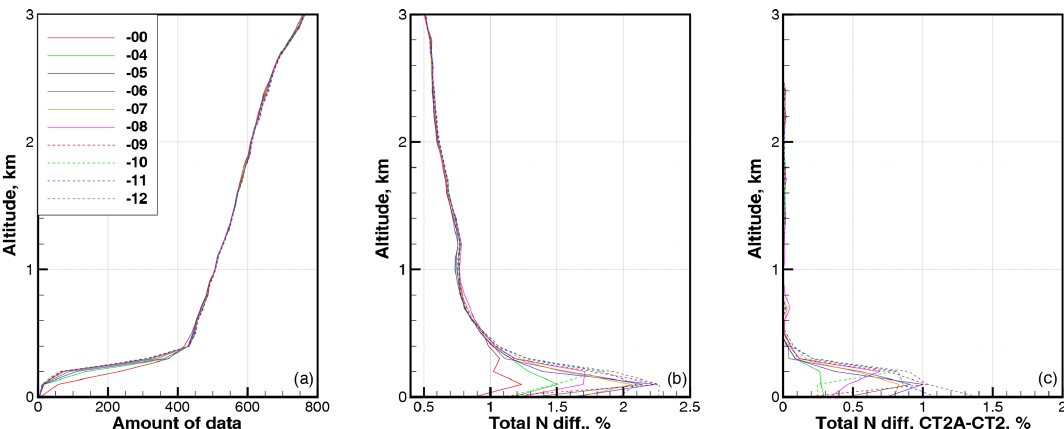
Figure 11. Statistics for latitude band 80–90 ◦ . (a) Amount of data. (b) RMS relative difference in refractivity COSMIC–ECMWF (cid:49)N CE . (c) RMS relative difference in refractivity CT2A–CT2. All are functions of the parameter β